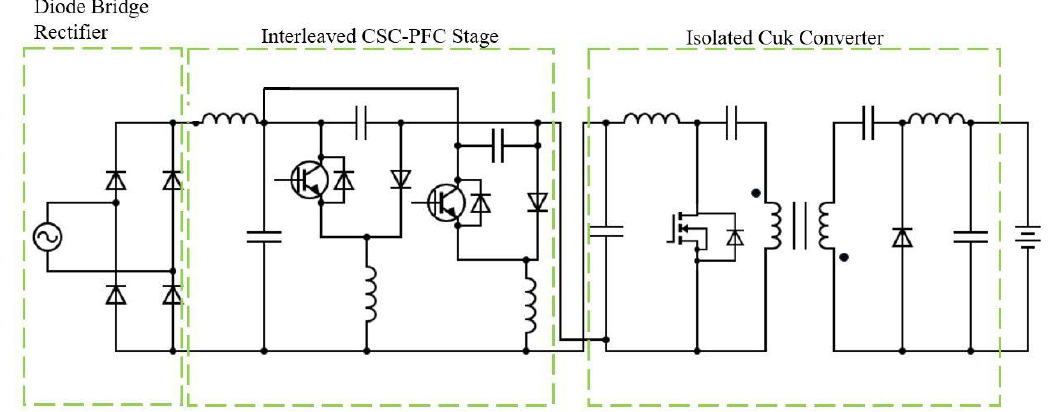
Figure 5. Isolated Cuk converter with canonical switching cell PFC [35].